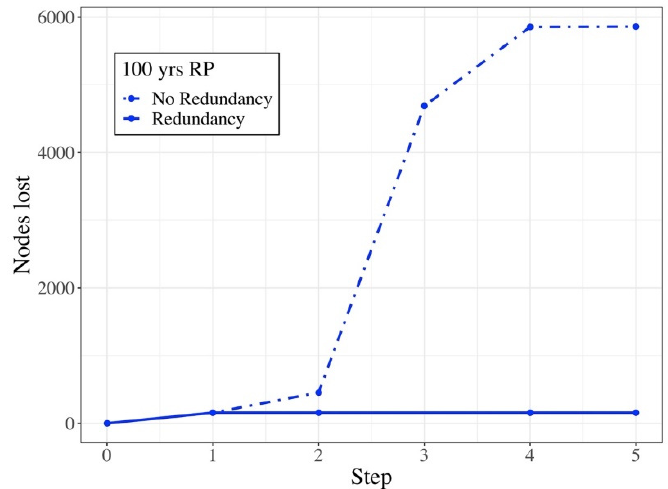
Figure 8. Impact propagations: comparison between a non-redundant and redundant graph (river scenario).